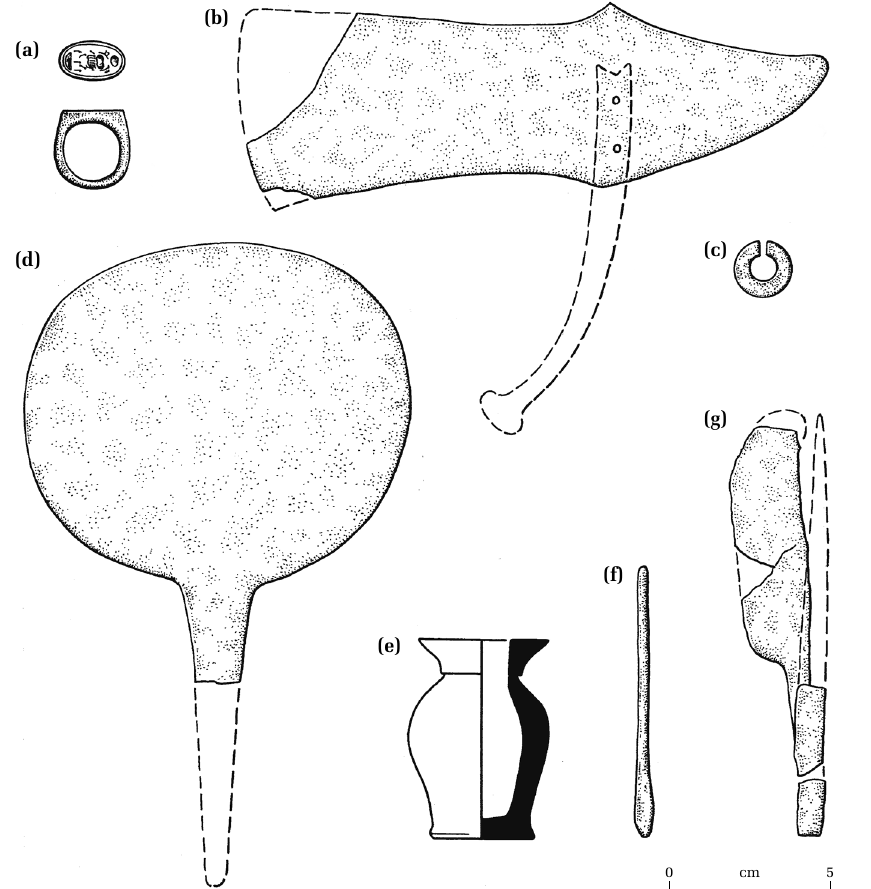
Figure 3 (above) Egyptian toiletry accessories from Tell el-‘Ajjul: (a) faience finger ring with the name of Tutankhanem, tomb 419 (Rockefeller Museum, no. 33.1708); (b) bronze mechak razor, tomb 418 (present location unknown); (c) bronze hair ring covered in gold leaf, tomb 1206 (British Museum no. 1949.2–12/26); (d) bronze mirror, tomb 1149 (Petrie Palestinian Collection, UCL Institute of Archaeology no. EXIII .18/3); (e) kohl jar, tomb 257 (Petrie Palestinian Collection, no. EXIII .76/2); (f) bronze cosmetic applicator, tomb 1030 (present location unknown); (g) bronze combination razor and “wig curler” (Petrie’s interpretation of the function of this object), area QP 1071 (Petrie Palestinian Collection, no. EXIII